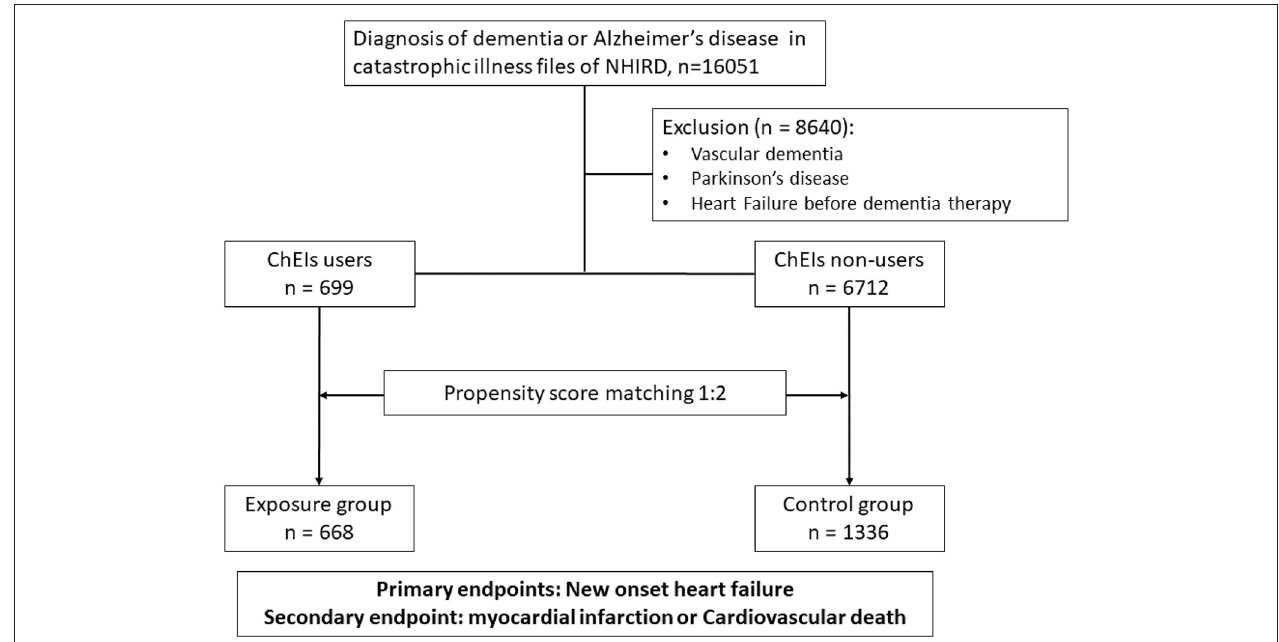
FIGURE 1 | Flow chart of patient enrolment in this